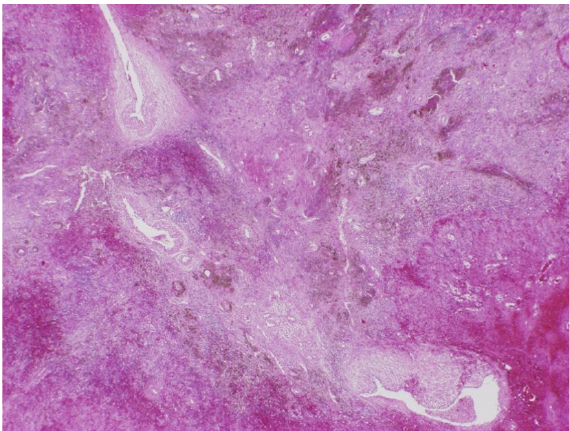
Figure 4: Microscopic findings, showing that the vessels in the dark brown spots were telangiectatic and thin walled, with intimal hyperplasia (hematoxylin and eosin staining, ×